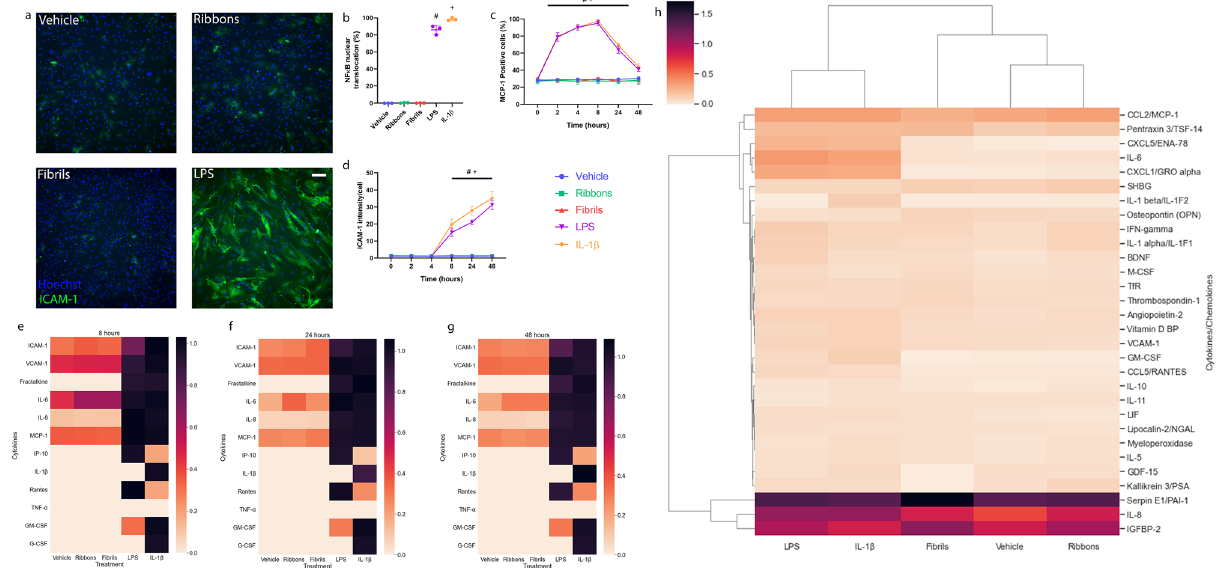
Figure 1. Inflammatory responses of pericytes treated with two α-syn preparations. Inflammatory responses of primary human brain pericytes when treated with vehicle, ribbons, fibrils, (100 nM), LPS (10 ng/mL) and IL-1β (10 ng/mL). ( a ) Representative immunocytochemistry images of ICAM-1 induction after 48 h treatment. Scale bar = 200 µm. Immunocytochemistry quantification of ( b ) NF-κB nuclear translocation after 1 h treatment, ( c ) MCP-1 and ( d ) ICAM-1 induction after times indicated ( n = 3 epilepsy cases , mean ± SD ). Pericytes were cultured and treated with vehicle, two α-syn preparations (100 nM), LPS (10 ng/mL) and IL-1β (10 ng/mL) before conditioned media were taken and cytokine secretion analysed by cytometric bead array. Heatmap analysis of cytokine secretion of pericytes after treatment at ( e ) 8 h, ( f ) 24 h and ( g ) 48 h ( n = 3 epilepsy cases). Pericytes were cultured and treated with vehicle, two different α-synuclein preparations (100 nM), LPS (10 ng/mL) and IL-1β (10 ng/mL) for 24 h before conditioned media were taken and cytokine secretion measured using a Proteome Profiler Human XL Cytokine Array Kit. Clustered heatmap analysis ( h ) of the top 30 secretions in pericytes ( n = 1, epilepsy case). # LPS, + IL-1β vs vehicle p < 0.05; one way ANOVA with Tukey’s multiple comparisons test or two way ANOVA with Tukey’s multiple comparisons